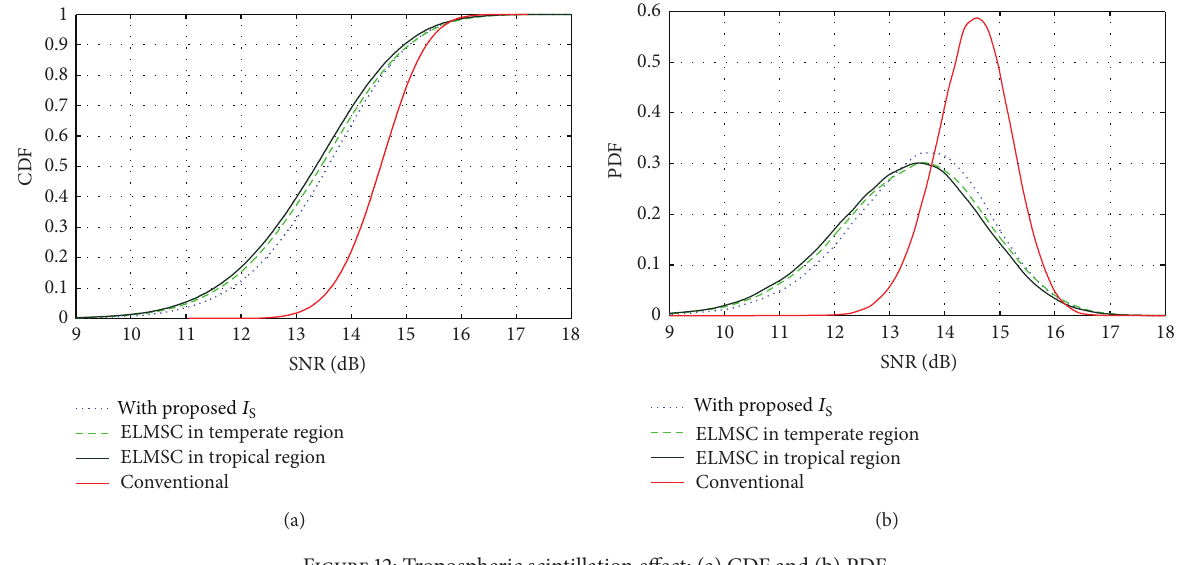
Figure 12: Tropospheric scintillation effect: (a) CDF and (b) PDF.